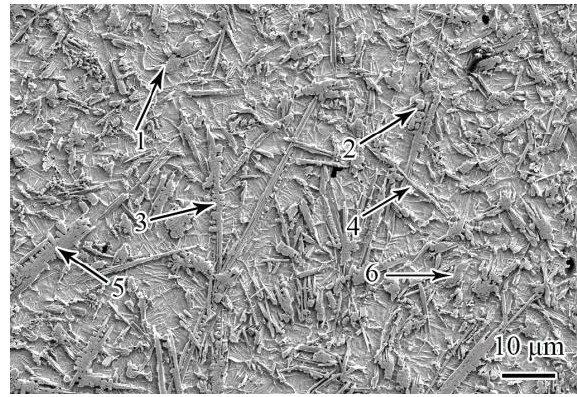
Figure 5. Microstructure of 30%/Ti-based alloy cladding layer. Table 5. Measurements of EPMA point area for each location shown in Figure 5. Position No.